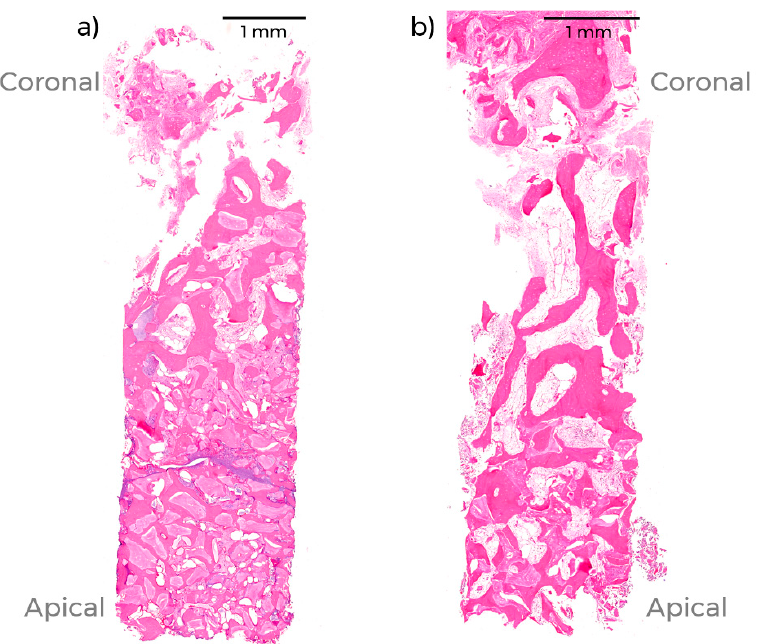
Figure 4. Photomicrographs of H &E-stained histologic specimens of ( a ) Case I and ( b ) Case II.